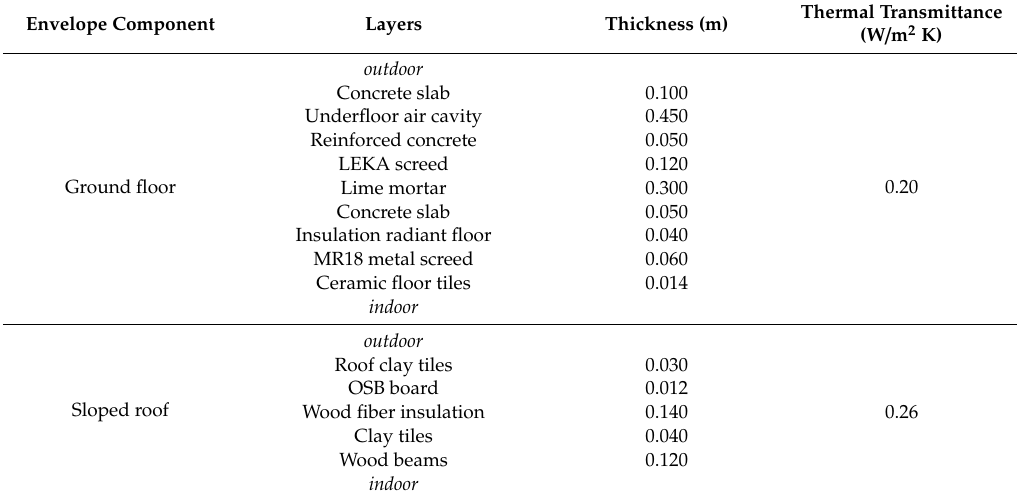
Table 2. Thermo-physical characteristics of the main opaque envelope components.